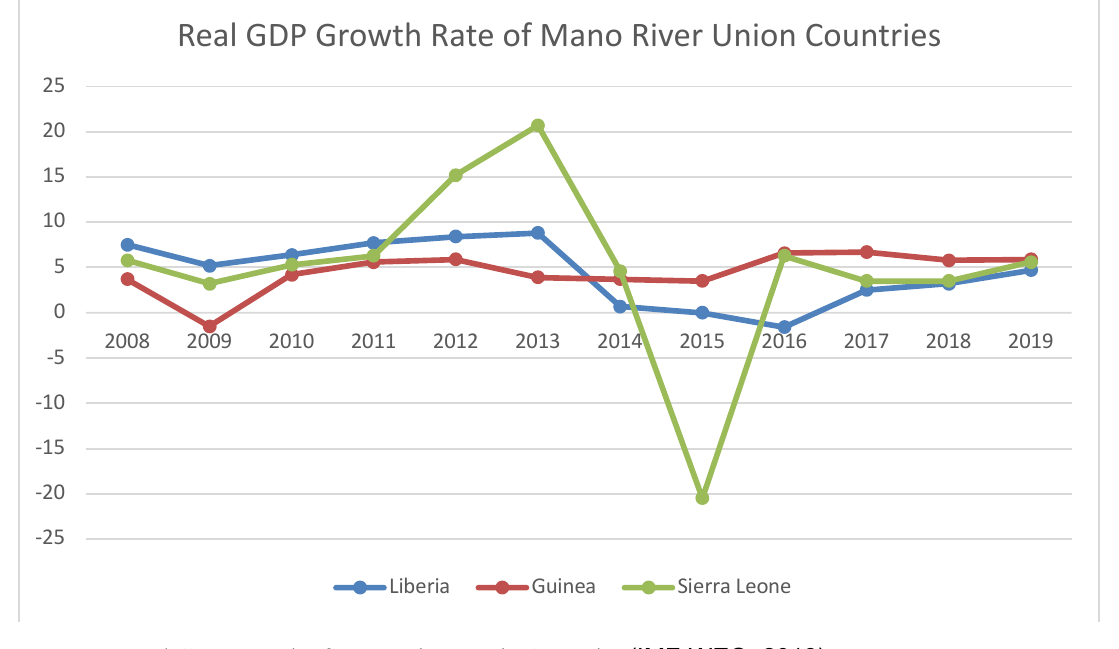
Figure 2: Real GDP growth of Mano River Basin Countries (IMF-WEO, 2018) Export Products and Major Trade Partners of MRB Countries in 2013, Just